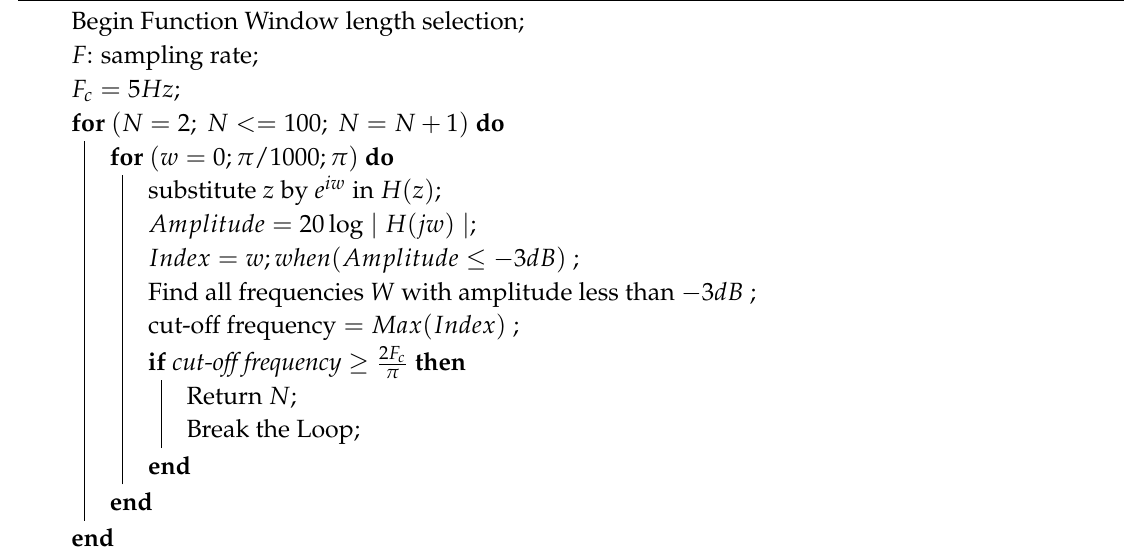
Algorithm 1: Pseudo Code for the Window Length Selection